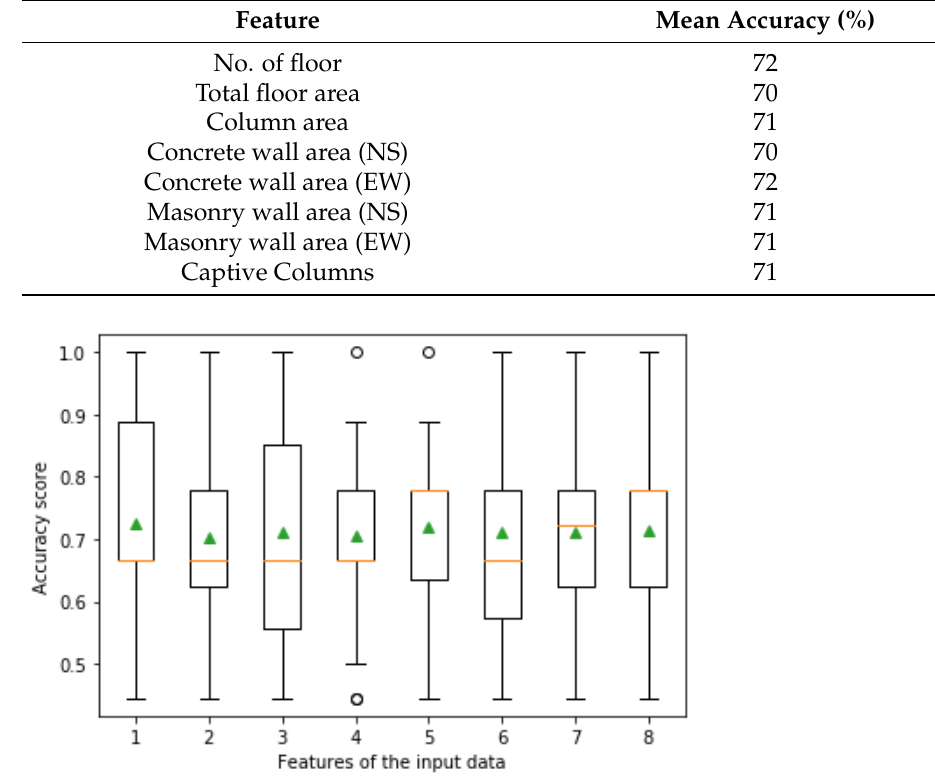
Figure 24. Pohang: Boxplot to represent the mean accuracy distribution achieved by hyper-tuning the input features.